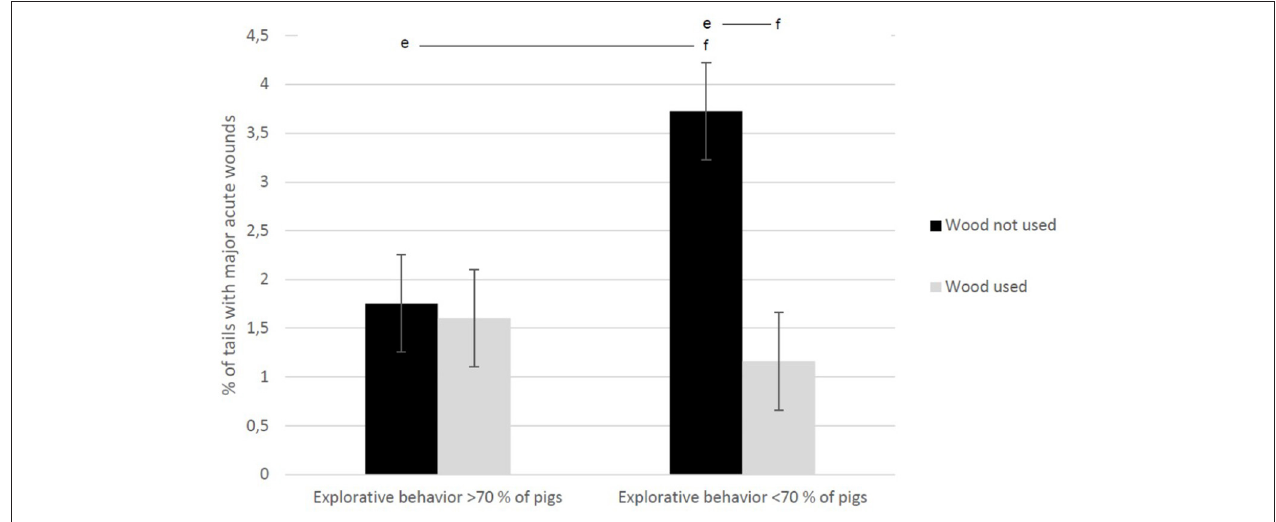
FIGURE 6 | Percentage of undocked, tails with major acute wounds evaluated at slaughterhouse. The finishing pigs originated from 84 herds, where the herd veterinarian collected the data during one herd health visit. The results are shown separately for herds using wood as enrichment and according to explorative behavior of standing animals if they were not eating, drinking, defecating, or urinating (interaction), as evaluated by a veterinarian during the herd health visit. The behavior was directed toward enrichment material and not toward pen structures or pen mates. Different letters represent statistical difference: ef p <